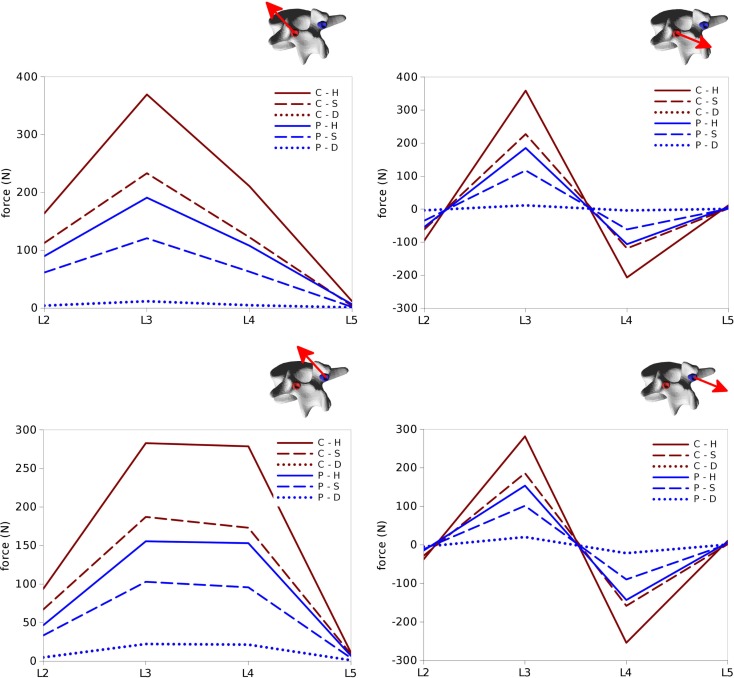
Total forces (left) and pull-out forces (right) at the screw–bone interfaces for the screws on the left side (top) and those on the right side (bottom) predicted for the six configurations of the test case.